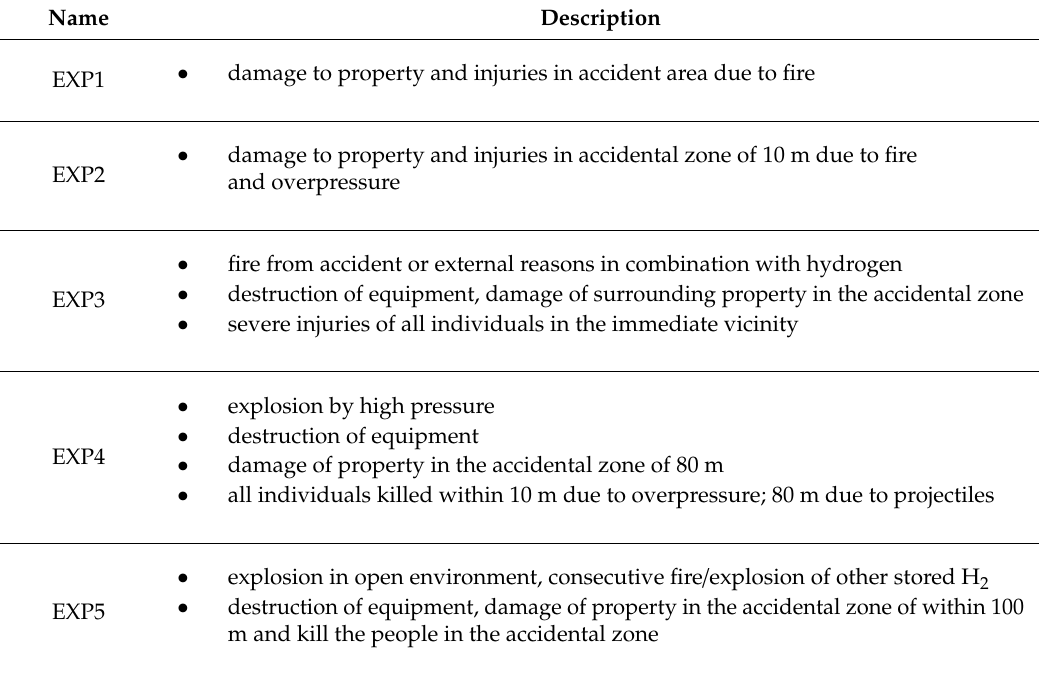
Table 12. Hydrogen Explosion Scenarios [58].